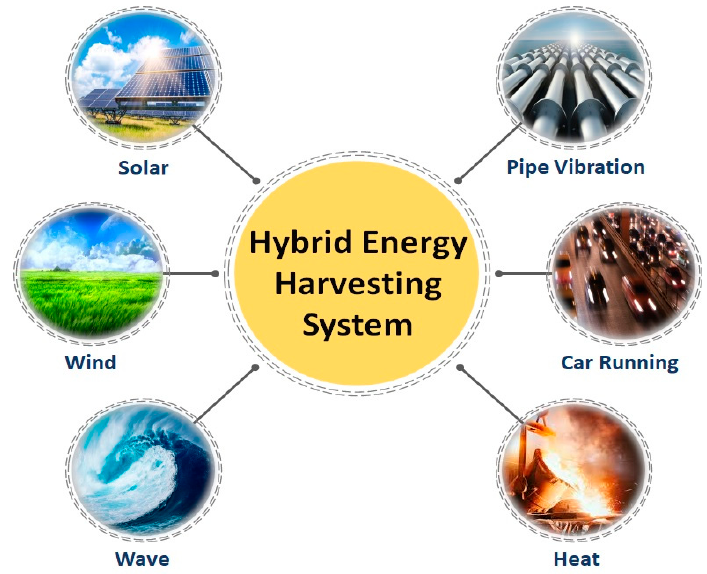
Figure 3. Potential applications of hybrid nanogenerators.